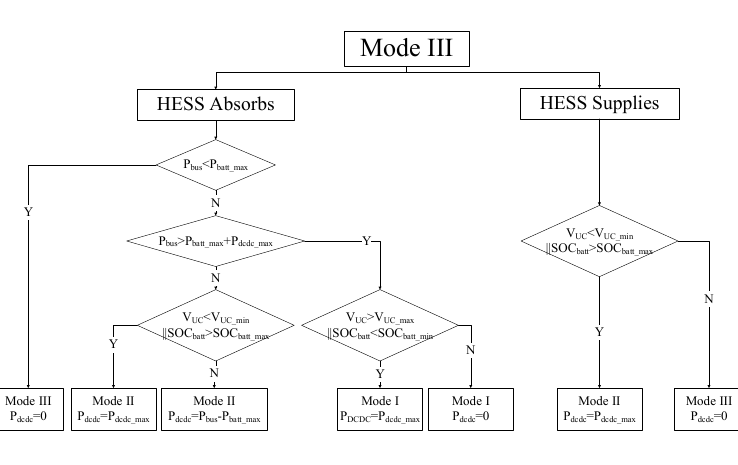
Figure 10. Control flowchart for Mode